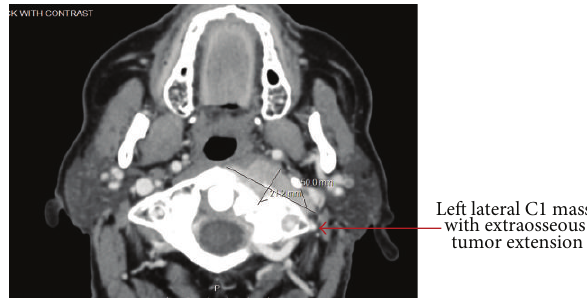
Figure 5: CT scan of left cervical C1